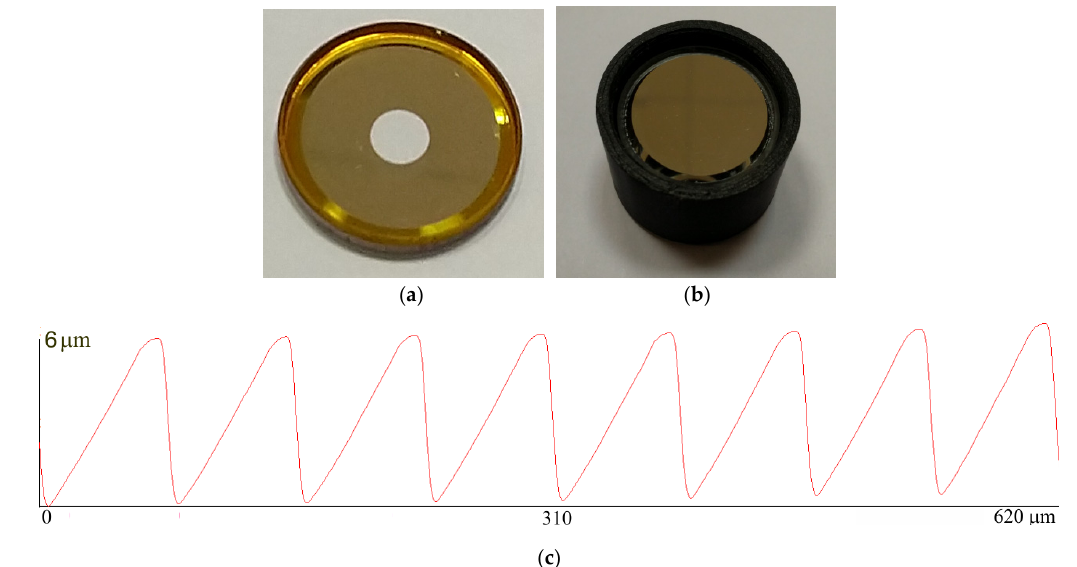
Figure 10. ( a ) External appearance of the fabricated reflecting harmonic annular lens with an annular zone with microrelief seen along the edge; ( b ) The external appearance of the imaging system with annular aperture as seen from the secondary mirror side; ( c ) The microrelief profile.